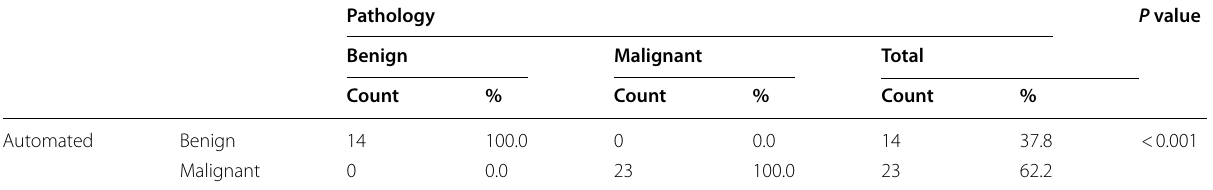
Table 7 Correlation between ABUS BIRADS and pathology